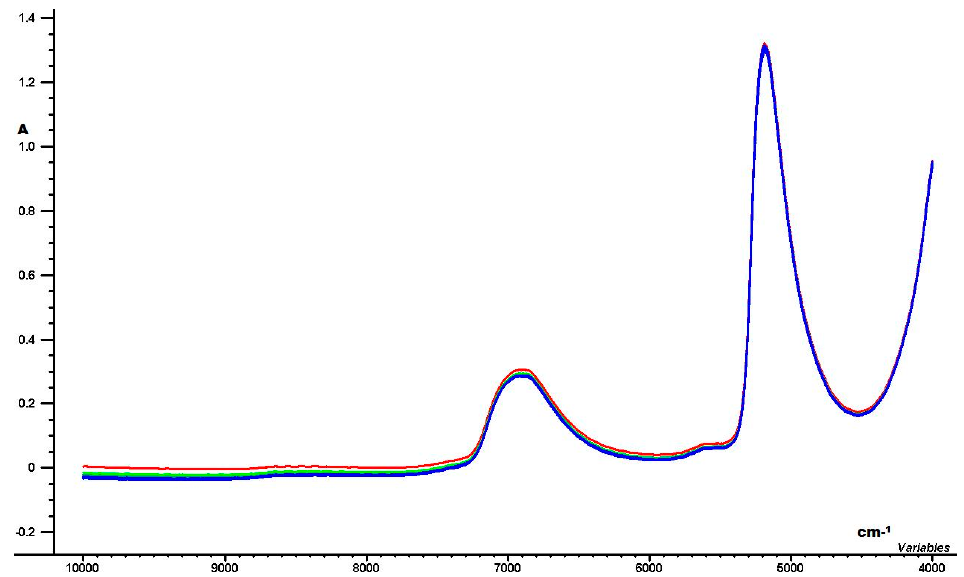
Figure 1. Fourier transform–near infrared (FT-NIR) spectra for all the caffeine standards and tea samples where A is for absorption.